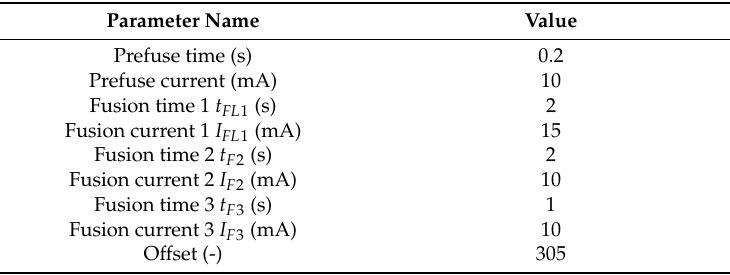
process quicker than in the case of standard fiber